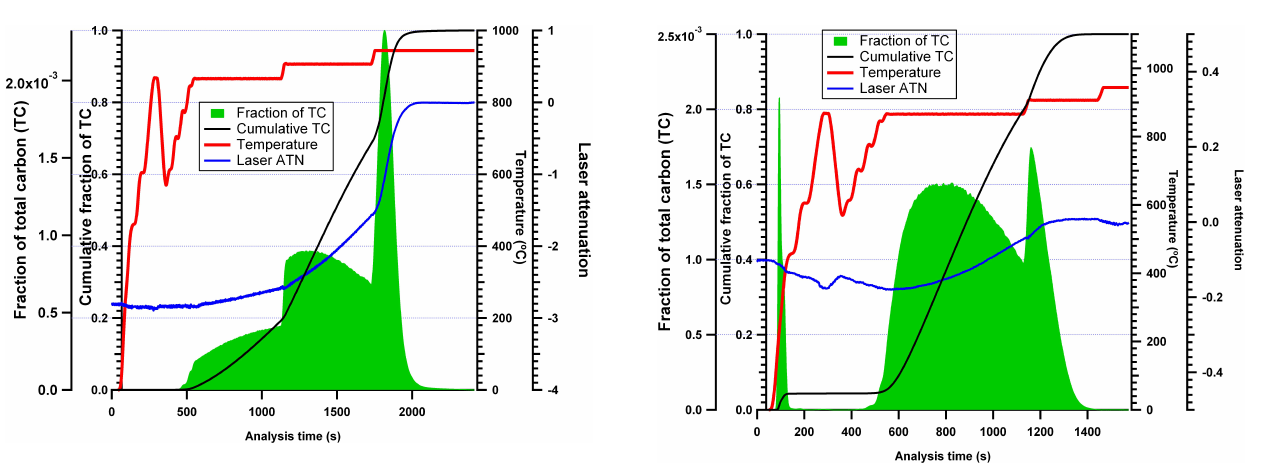
Fig. 6. This graph is the same as shown in Fig. 5 except the analysis is for GTS-80 covered with 5% of pyrene (Sample No.